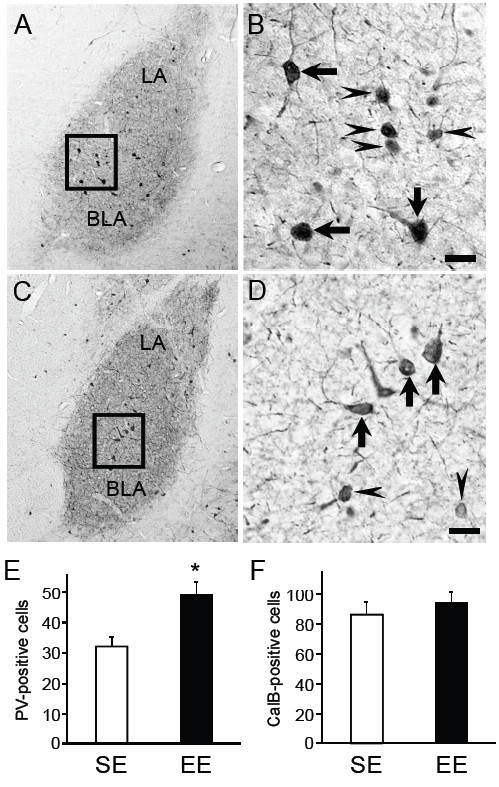
Immunohistochemical staining for parvalbumin (PV) of EE and SE rats, and cell-counting for PV and calbindin D-28k (CalB) in the basolateral amygdala (BLA). Photomicrographs show staining for PV of EE (A, B) and SE (C, D) rat amygdala area. High density of PV-positive neurons in BLA [the lateral (LA) and basal nuclei (BA)] was observed (A, C). B and D, higher magnification of the square area in A and C. PV-positive neurons differed in cell sizes—large immunoreactive cells (rectangular diameter of perikaryon > 25 μm, arrows) and small immunoreactive cells (rectangular diameter of perikaryon < 25 μm, arrowheads). The total number of immunoreactive cells in BLA was compared between the SE and EE rats (E and F). In the EE rats, the number of PV-positive neurons was increased (B, E), while the number of CalB-positive neurons in the EE rats was comparable to that in the SE rats (F). Data represented mean value per section. * Significant difference from SE rats, p < 0.05. Scale bars = 25 μm in B and D.